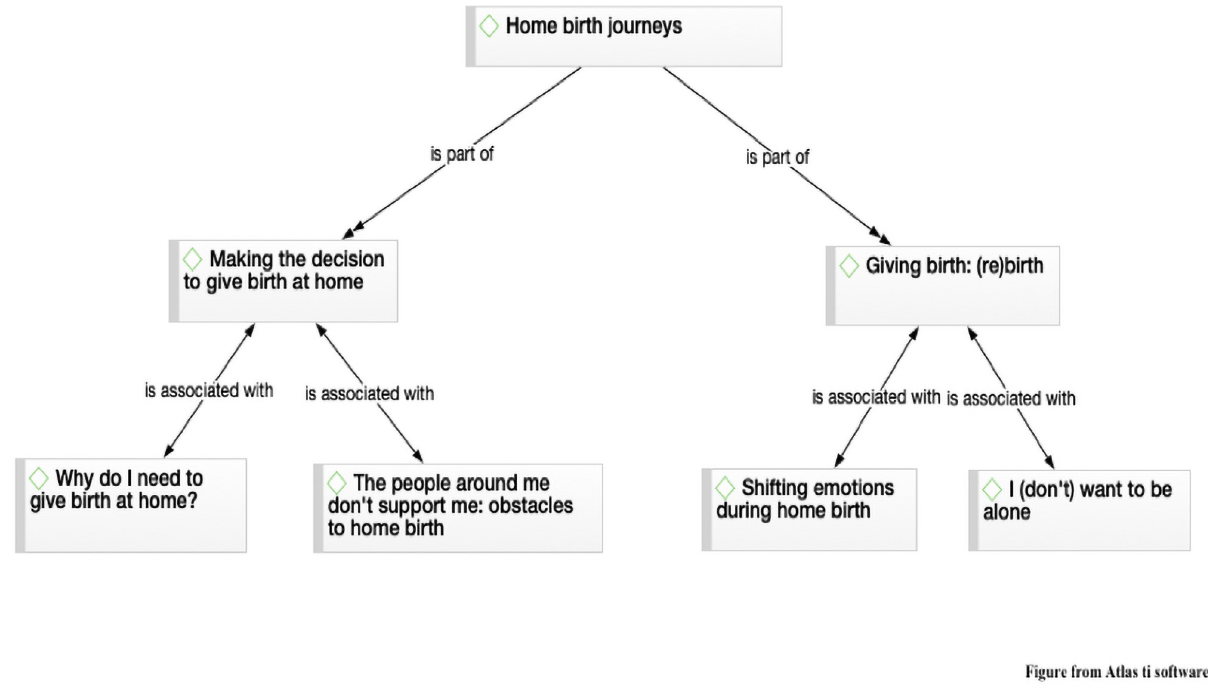
Fig 3. Categories for